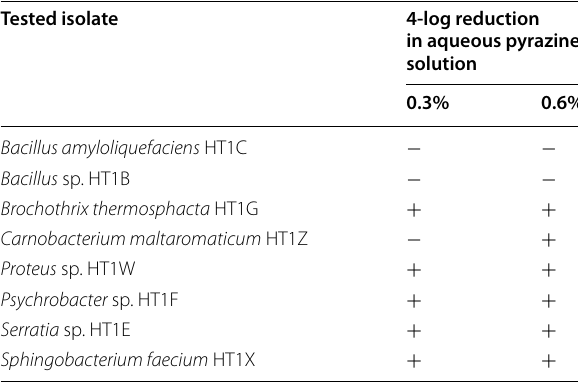
Pure cultures of isolates obtained from processed meat products were incubated in aqueous pyrazine solutions. Combinations of isolates and pyrazine concentrations that led to a 4-log reduction are labeled with ‘ lower reduction rates are labeled with ‘